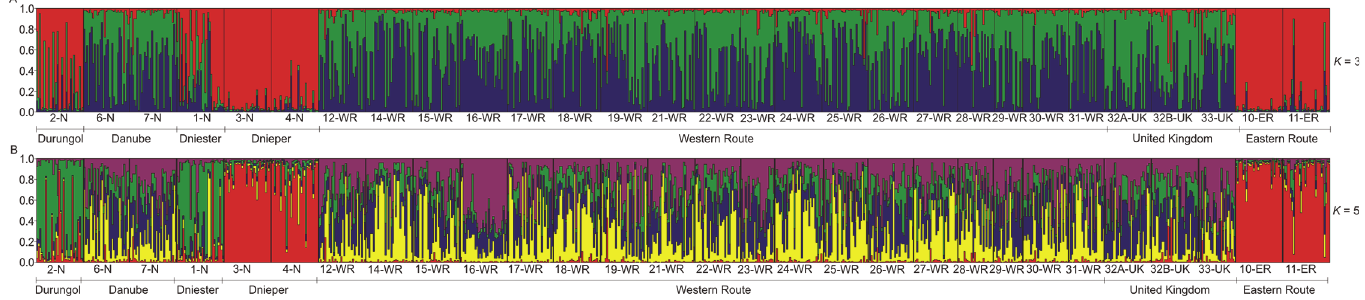
Fig 4. Bayesian clustering of Dikerogammarus villosus based on six microsatellite loci in 29 populations collected in native and invaded area with K = 3 (A); and K = 5 (B). Acronyms refer to sites as explained in Table 1. Each individual is represented by a thin vertical line, with proportional membership in different clusters indicated by colors. Black vertical lines separates sampling sites, with site identification indicated below the